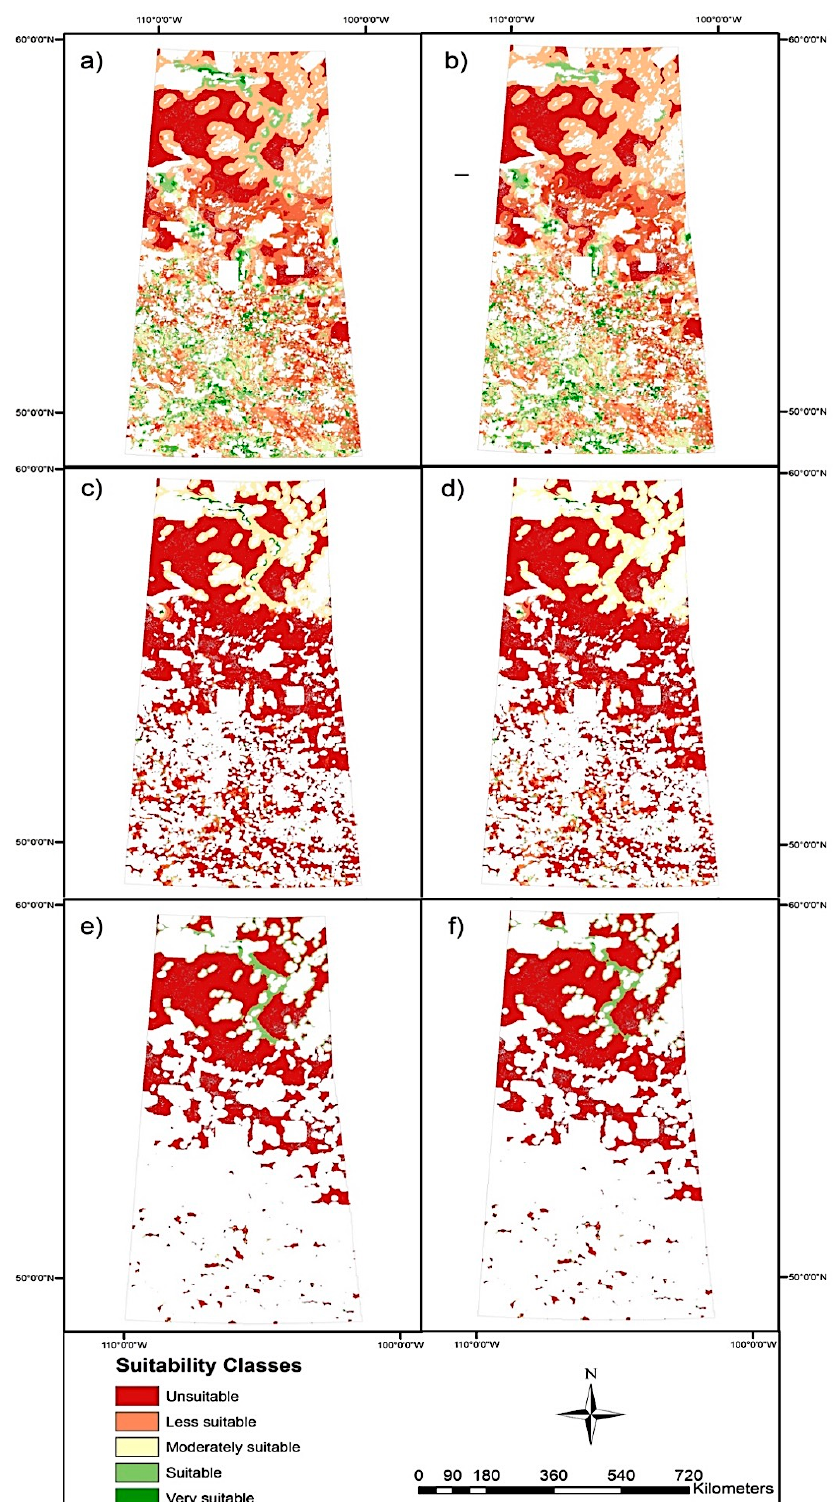
Figure 7. Open, Normal, and Restrictive cases final maps with the two-different set of weights: ( a ) Open case final map with the first set of weights; ( b ) Open case final map with the second set of weights; ( c ) Normal case final map with the first set of weights; ( d ) Normal case final map with the second set of weights; ( e ) Restrictive case final map with the first set of weights; and ( f ) Restrictive case final map with the second set of weights.